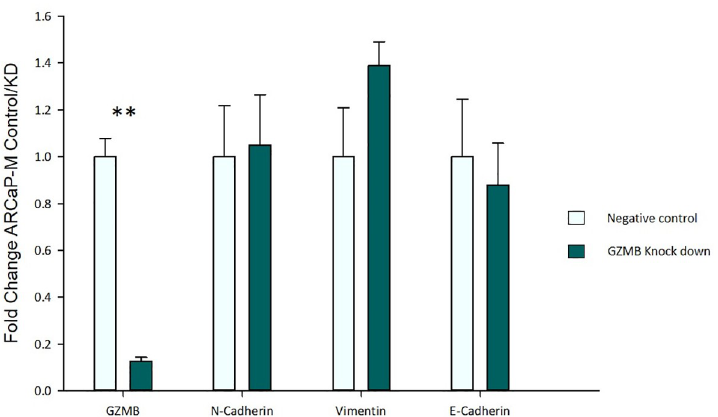
Fig 3. Relative gene expression of GZMB and EMT biomarkers after 48 hours of siRNA knockdown as measured by qRT-PCR. The relative expression is compared to the endogenous control (GAPDH). These results show that GZMB knockdown does not affect the expression of EMT biomarkers when compared to the negative control transfected with scrambled siRNA. Asterisks indicate statistical significance ( �� : p-value < 0.01).